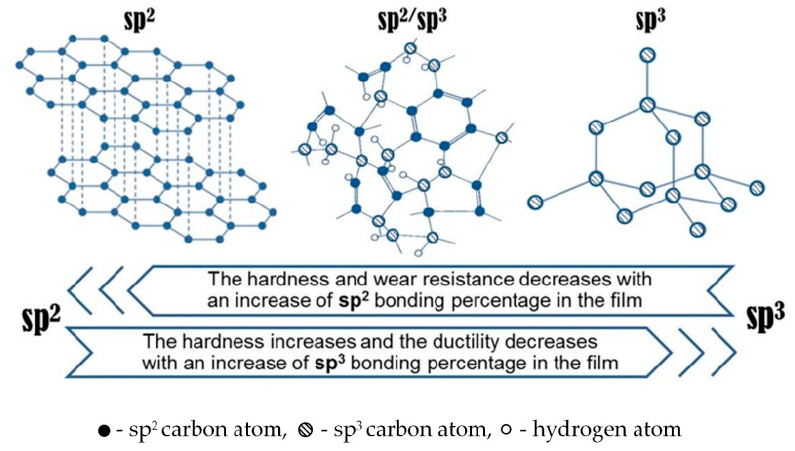
Figure 1. Different hybridizations of carbon in diamond-like coatings (DLC) films. Figure 1. Di ff erent hybridizations of carbon in diamond-like coatings (DLC)